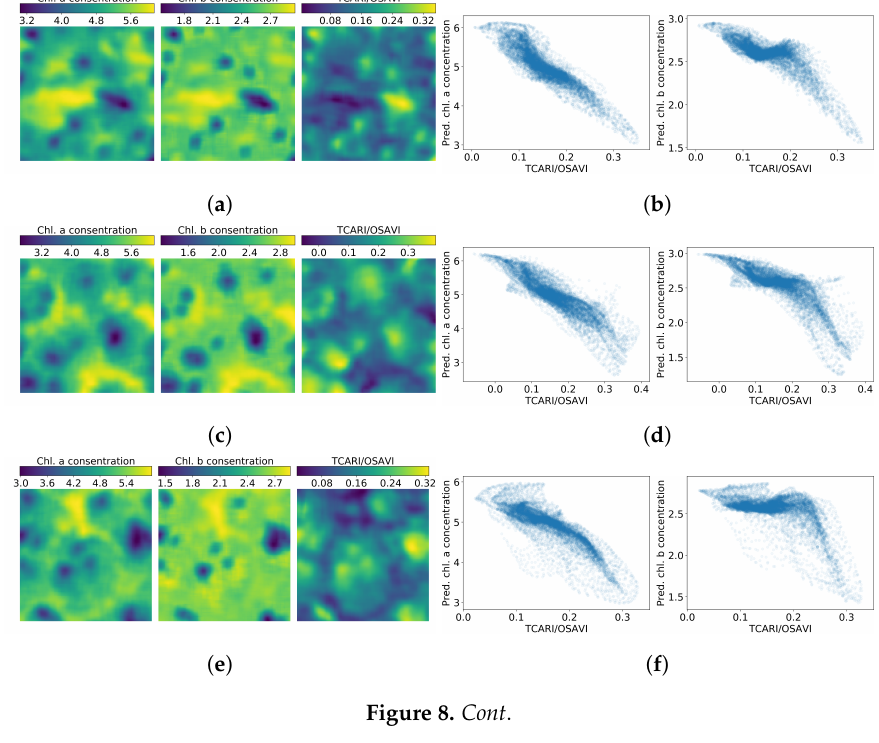
The predicted chlorophyll a and b correlated with the empirical TCARI in the plots 1–7 described in OSAVI Figure 5. In the spruce-dominant plots, the correlation coefficient was, on average, − 0.9 for chlorophyll a and − 0.7 for chlorophyll b . In the birch-dominated plots, the corresponding average correlation coefficients were − 0.89 and − 0.77 while in all of the plots 1–7 they were − 0.87 and − 0.68. The results for the plot 8 were − 0.82 for chlorophyll a and − 0.76 for chlorophyll b (Figures 8 and 9 and Table 5).